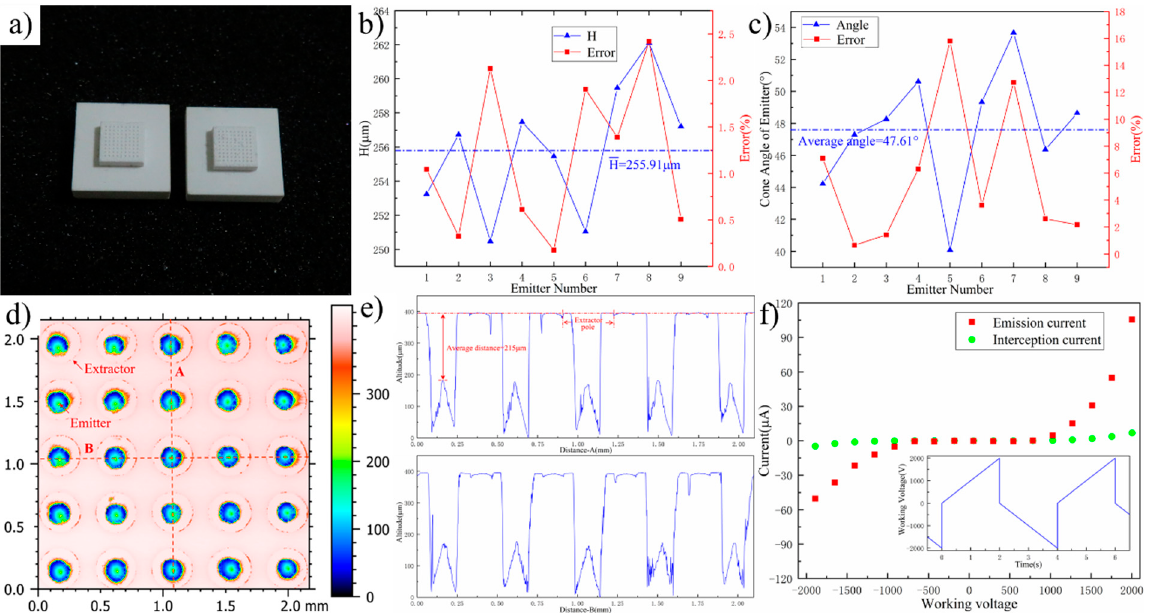
Figure 15. ( a ) The emitter of sintered borosilicate glass (Por.5), the ( b ) height and ( c ) the cone angle of emitter for the test samples, ( d ) thruster assembly effect and ( e ) the distance between emitter and extractor, ( f ) the I–V characteristics for Por.5 emitter.